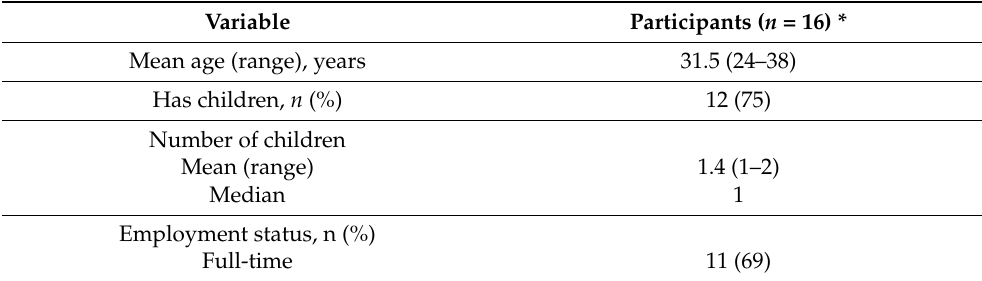
Table 2. Demographic characteristics of MacKillop employee interview and focus group